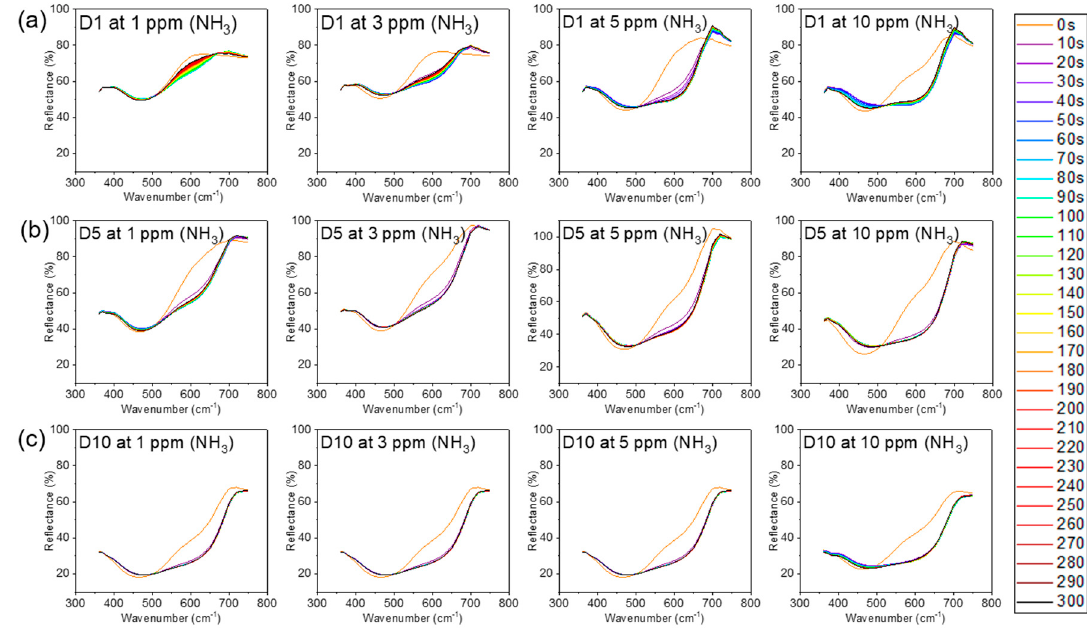
Figure 6. Time dependence of the reflectance of nanofibers at various NH 3 concentrations (1, 3, 5, and 10 ppm): ( a ) dye 1 wt %, ( b ) dye 5 wt %, and ( c ) dye 10 wt %.